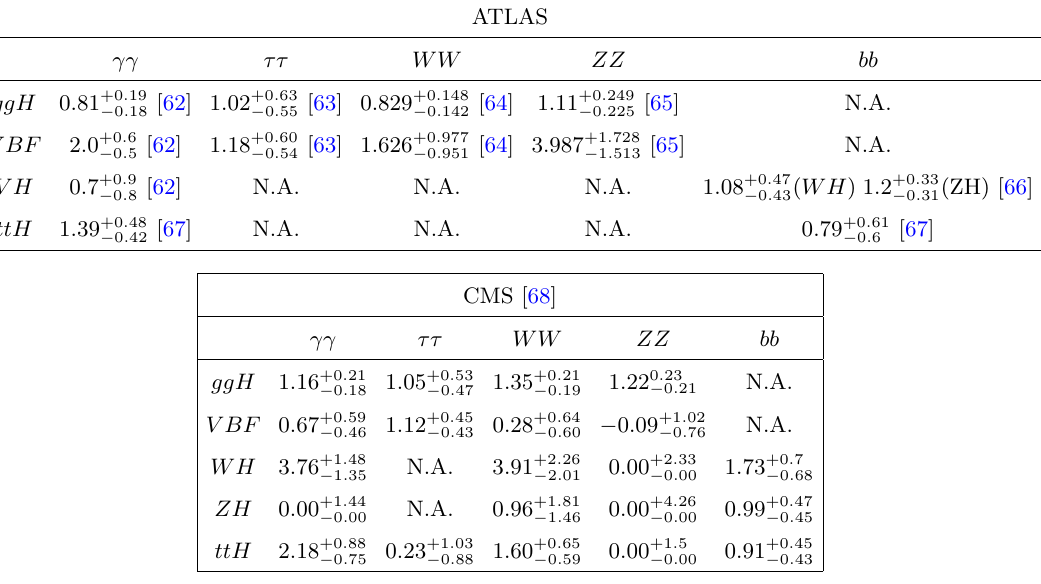
Table 1 . Higgs signal measurements used in the global